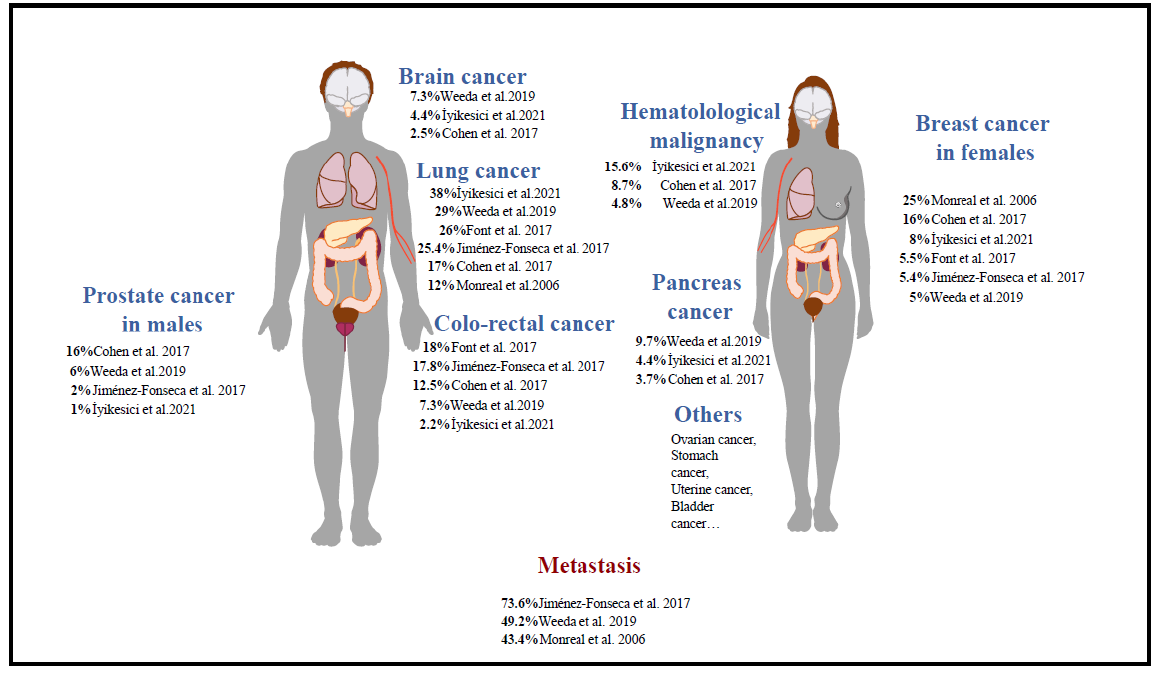
Figure 2. PE incidence among cancer sites associated with PE